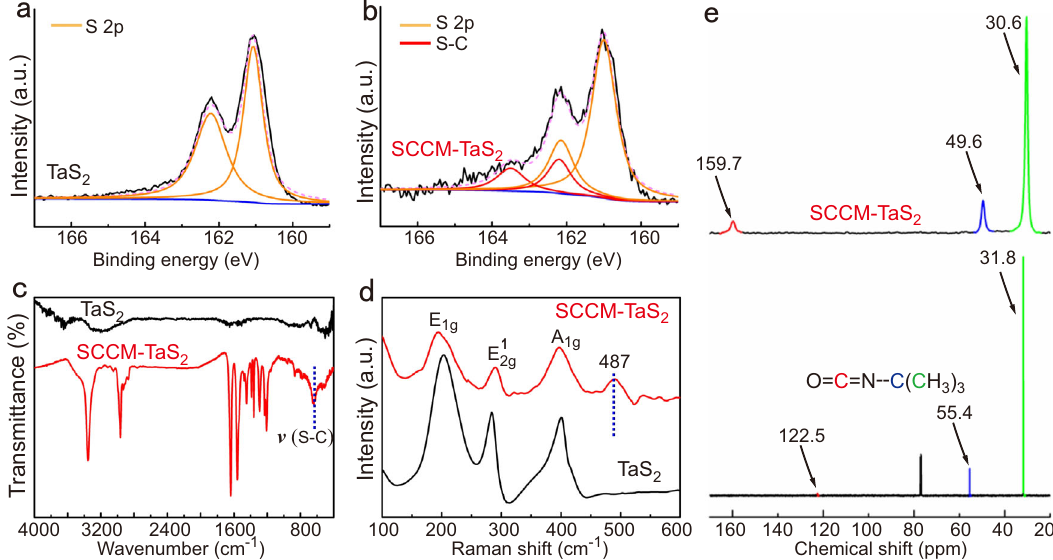
Fig. 3 | Chemical and spectral characterization from the pristine TaS 2 and SCCM-TaS 2 hybrid structure. XPS of S 2 p regions from the pristine TaS 2 single crystals ( a ) and SCCM-TaS 2 hybrid structure ( b ). c FTIR spectrum of pristine TaS 2 single crystal and SCCM-TaS 2 hybrid structure. d Raman spectrum of pristine TaS 2